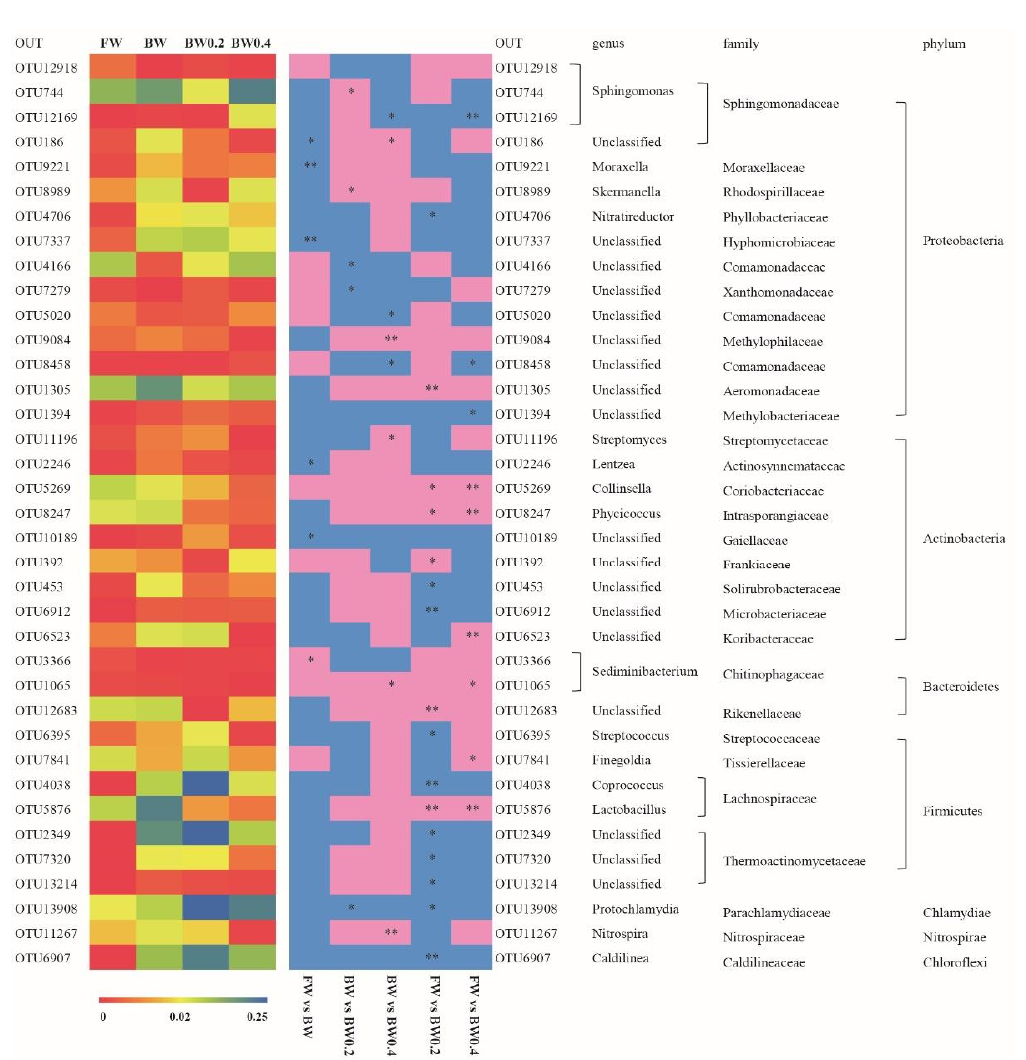
Figure 6. Heatmap analysis of 37 OTUs. The left heatmap includes the color bar of each OTU average value of three samples in each treatment. The right heatmap includes the color bars representing the di ff erence of OTU in O. niloticus between two treatments. The pink bar suggests that the abundance of OTUs is higher and the blue bar suggests that the abundance of OTUs is lower. A single asterisk (*) indicates a significant di ff erence ( p < 0.05), and two asterisks (**) indicate an extremely-significant di ff erence ( p < 0.01). The taxonomy of the OTUs (genus, family, and phylum) is depicted on the figure’s right. FW denotes freshwater; BW denotes brackish water; BW 0.2 and BW 0.4 denote brackish water with 0.2% and 0.4% β -glucan,